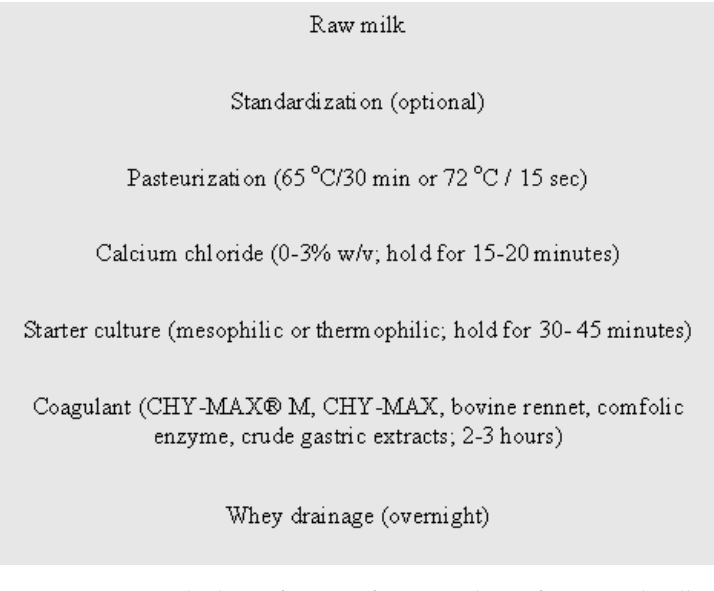
Figure 2. General scheme for manufacturing cheese from camel milk.